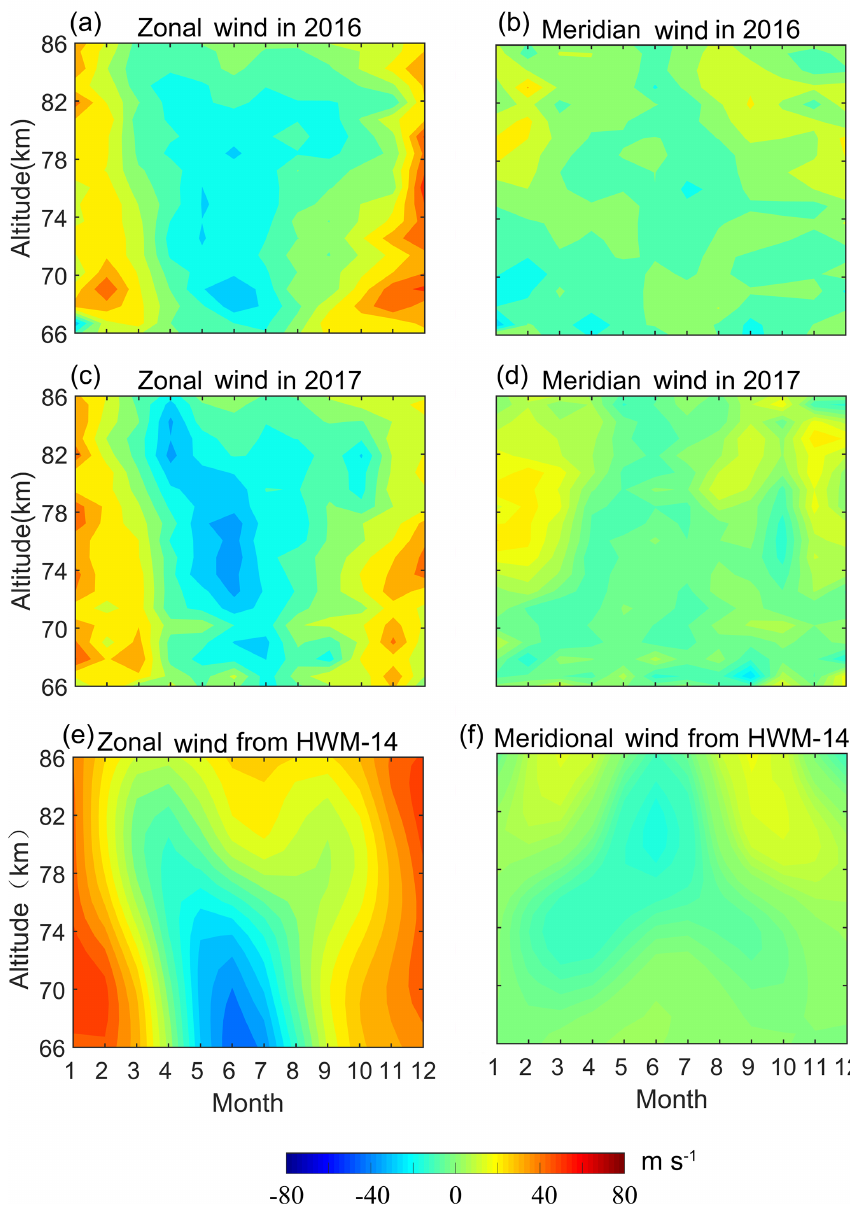
Figure 12. The contour plots of the monthly mean zonal (a, c, e) and meridional (b, d, f) winds in the mesosphere observed by the Wuhan MST radar during January 2016–December 2016 and January 2017–December 2017. HWM-14 model-estimated winds (e, f) for Wuhan region during the same